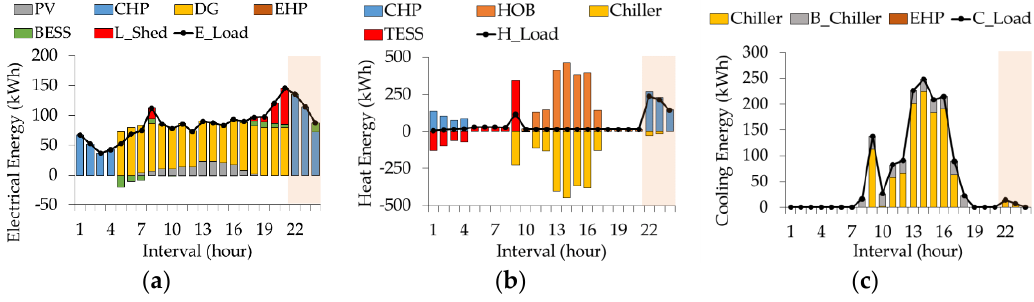
Figure 17. Energy balancing: ( a ) Electrical Energy; ( b ) Heat Energy; ( c ) Cooling Energy.